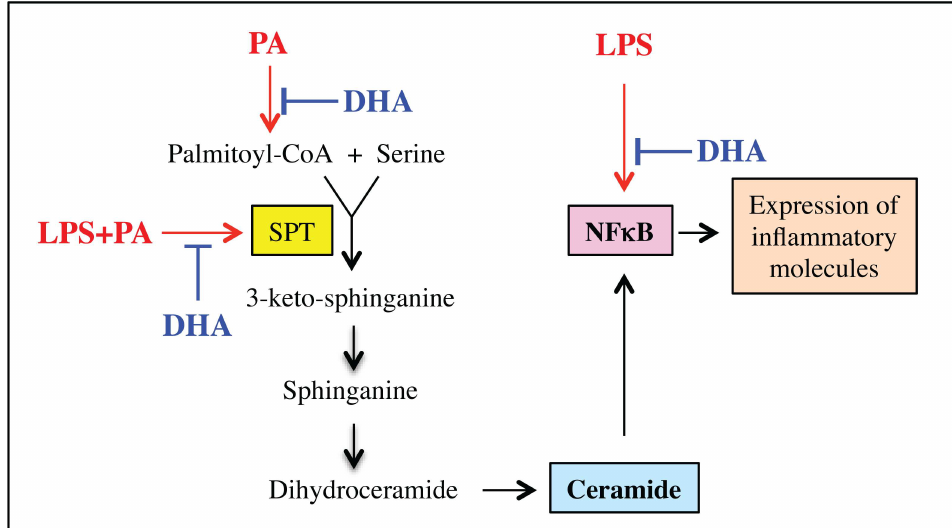
Fig 6. Schematic diagram to show the proposed mechanism involved in the inhibition by DHA of proinflammatory gene expression stimulated by LPS or LPS plus PA in RAW264.7 macrophages.